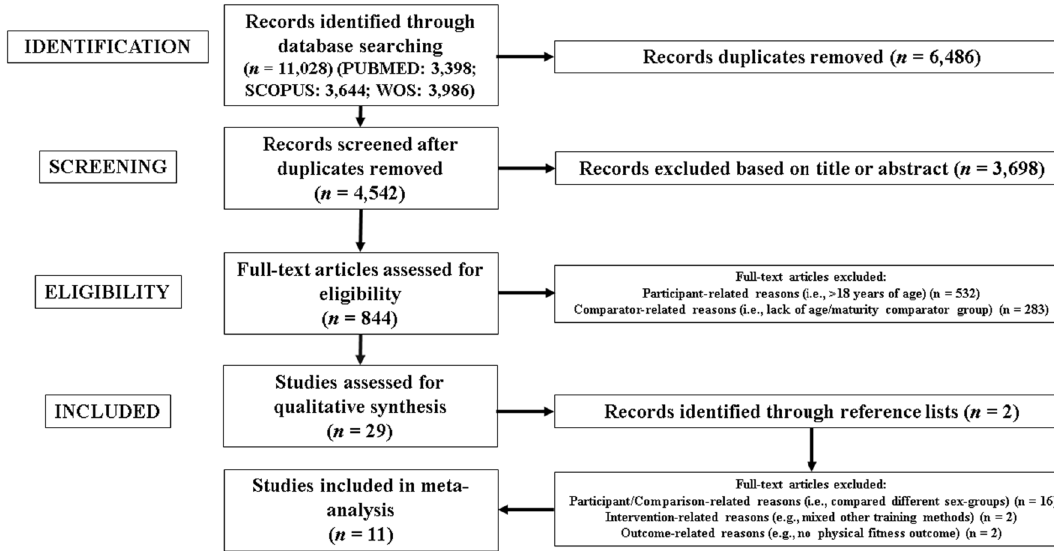
Fig. 1 Flow chart illustrating the study selection process